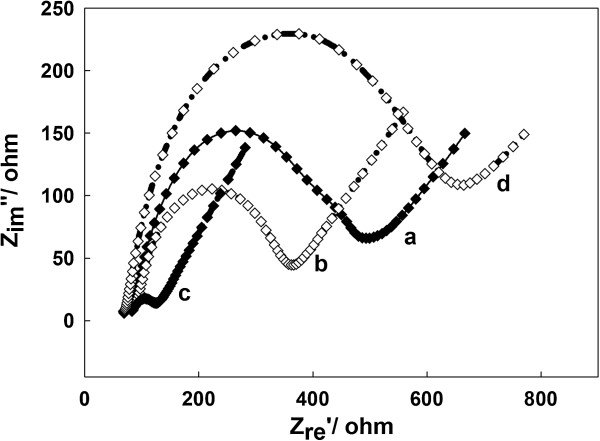
Impedance spectrum of various electrodes in 5.0 mM K3Fe(CN)6/K4Fe(CN)6 (1:1) containing 0.1 M KCl. Bare electrode (curve a), ss-DNA/GR modified electrode (curve b), PtAuNP/ss-DNA/GR modified electrode (curve c), and GOD/PtAuNP/ss-DNA/GR modified electrode (curve d).